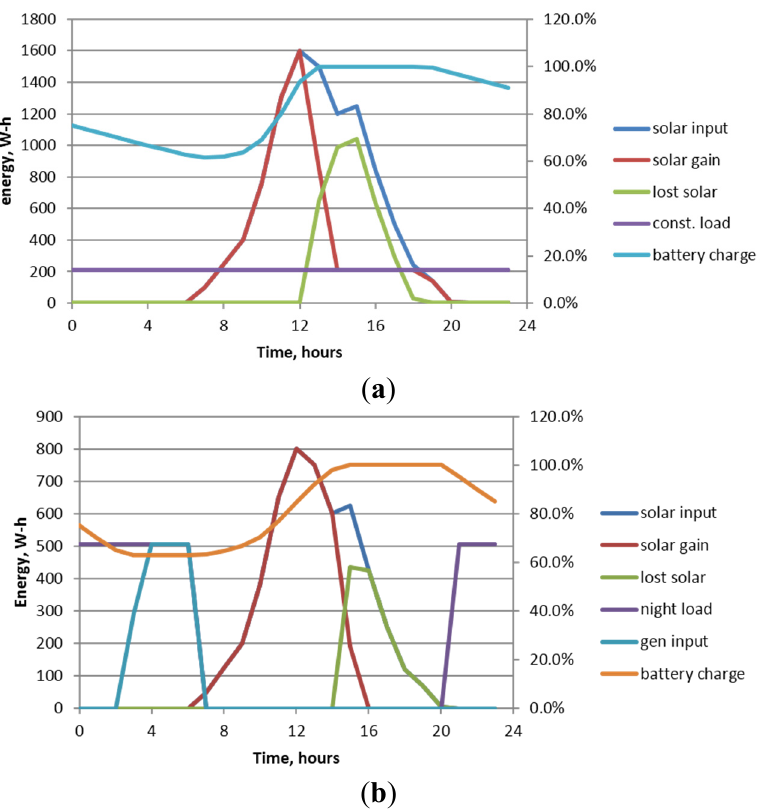
Figure 5. ( a ) Energy flows and state of battery bank charge for sunny day with constant electrical load over 24 h with double the solar input and double the battery bank storage capacity; ( b ) Energy flows and state of battery bank charge for sunny day with constant electrical load concentrated during nighttime hours with double the battery bank storage